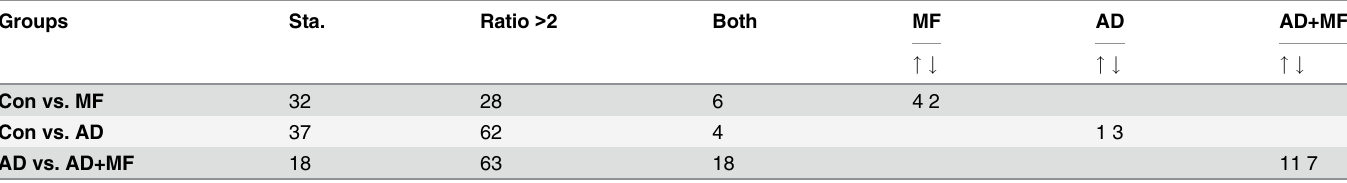
Table 1. The amount of differential proteins expressed in the rat hippocampus after exposure to 50 Hz and 400 μ T ELF-EMF for 60 days. Groups Sta.